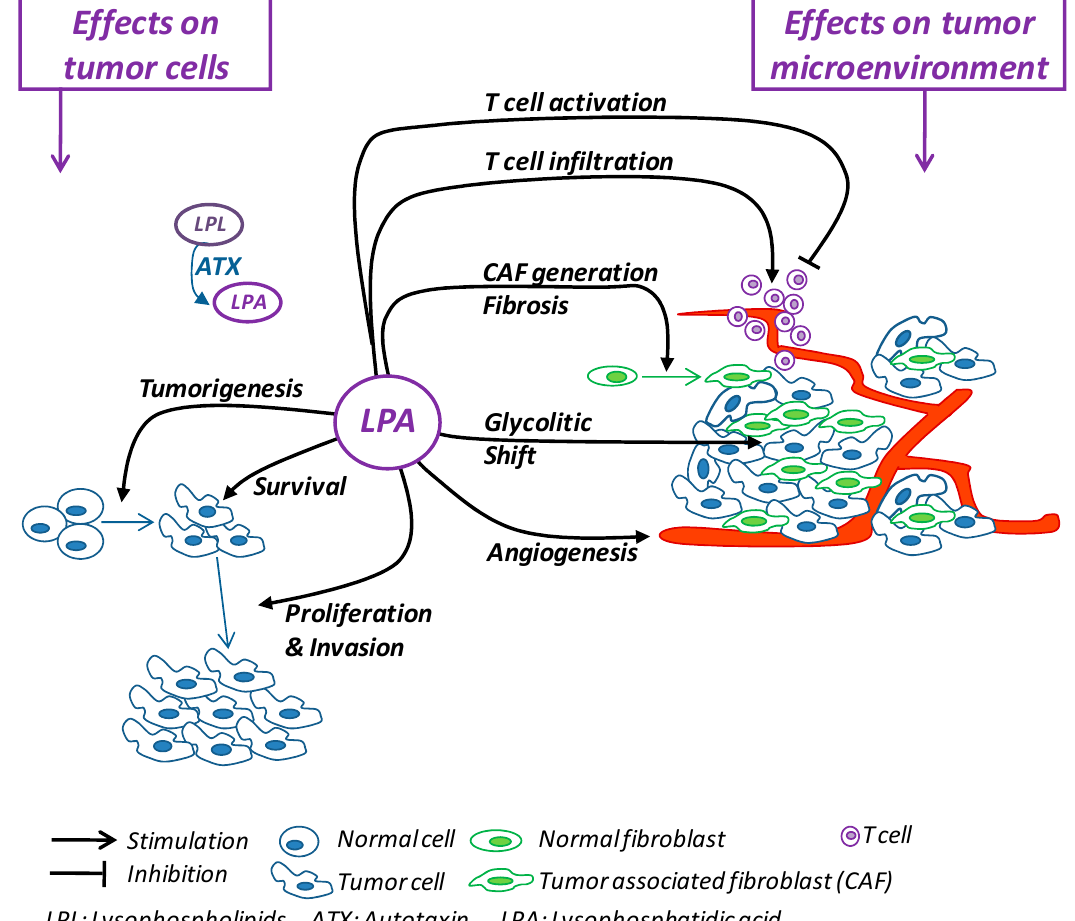
Figure 1. Schematic summary of the effects exerted by LPA on tumor cells and on the tumor microenvironment.